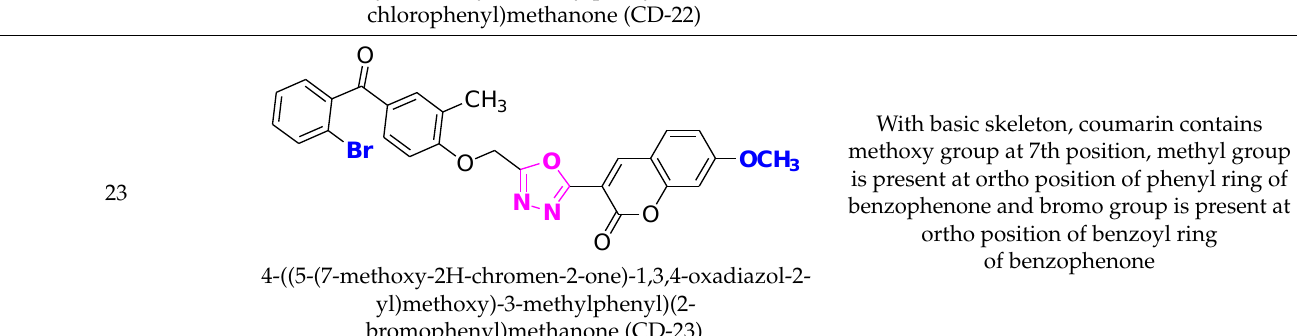
With basic skeleton, coumarin contains methoxy group at 7th position, methyl group is present at ortho position of group is present at ortho position of